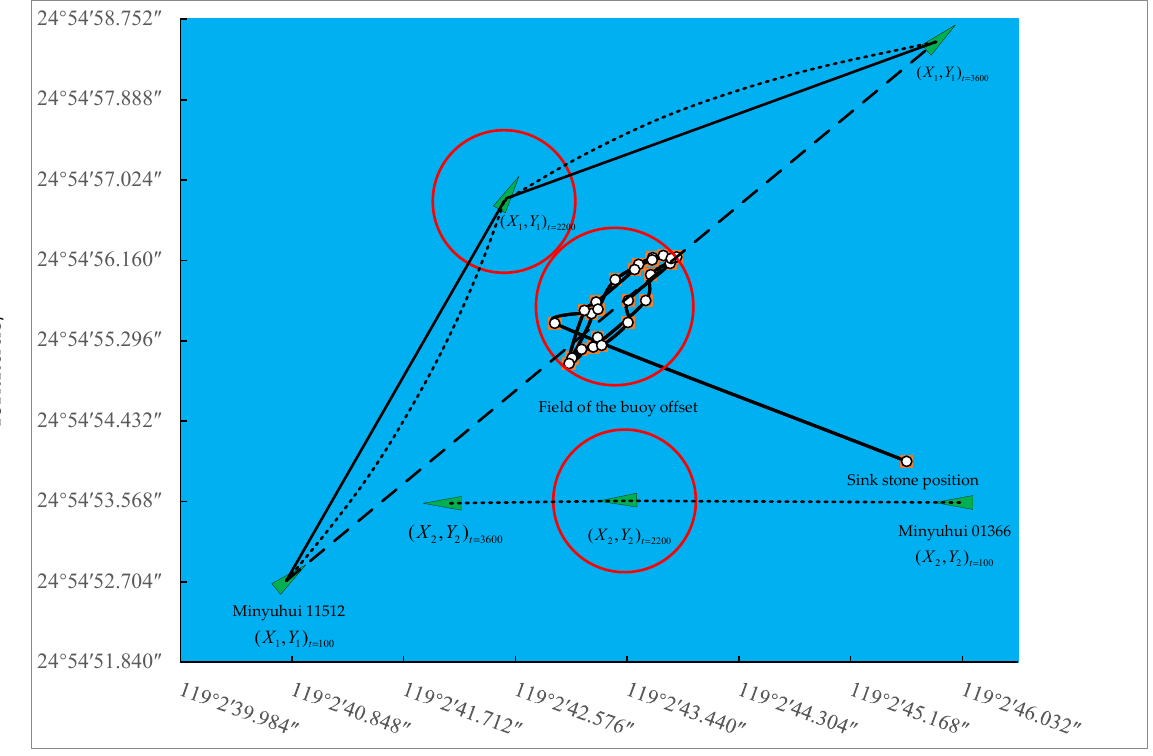
Figure 22. Ship path planning